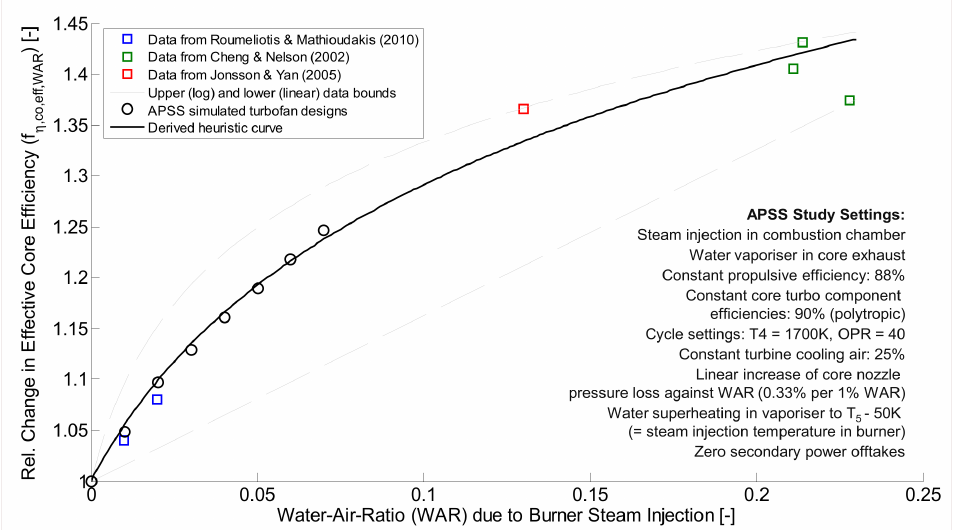
Figure 7. Semi-empirical derivation of heuristic correlation for GT effective core efficiency improve- ment versus water-to-air ratio due to burner steam